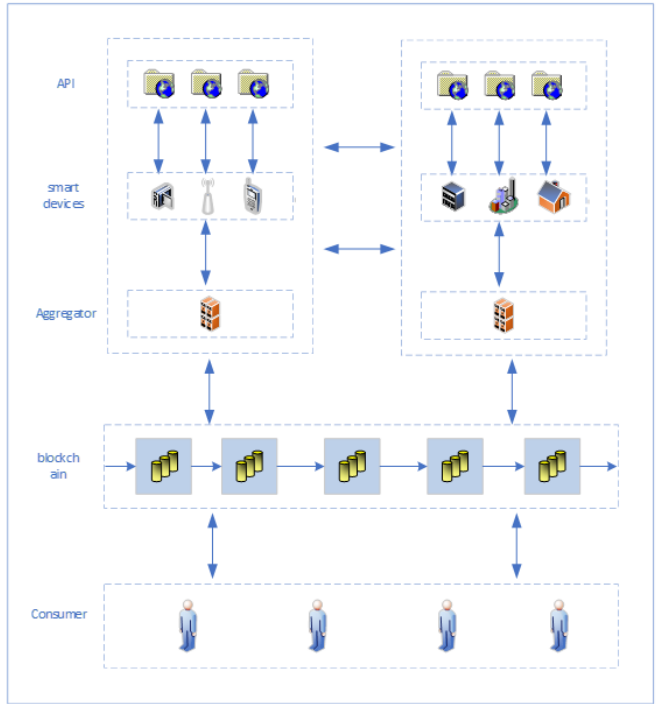
Figure 4. Data aggregation and reconstruction of privacy protection Internet of Things based on blockchain and homomorphic encryption.